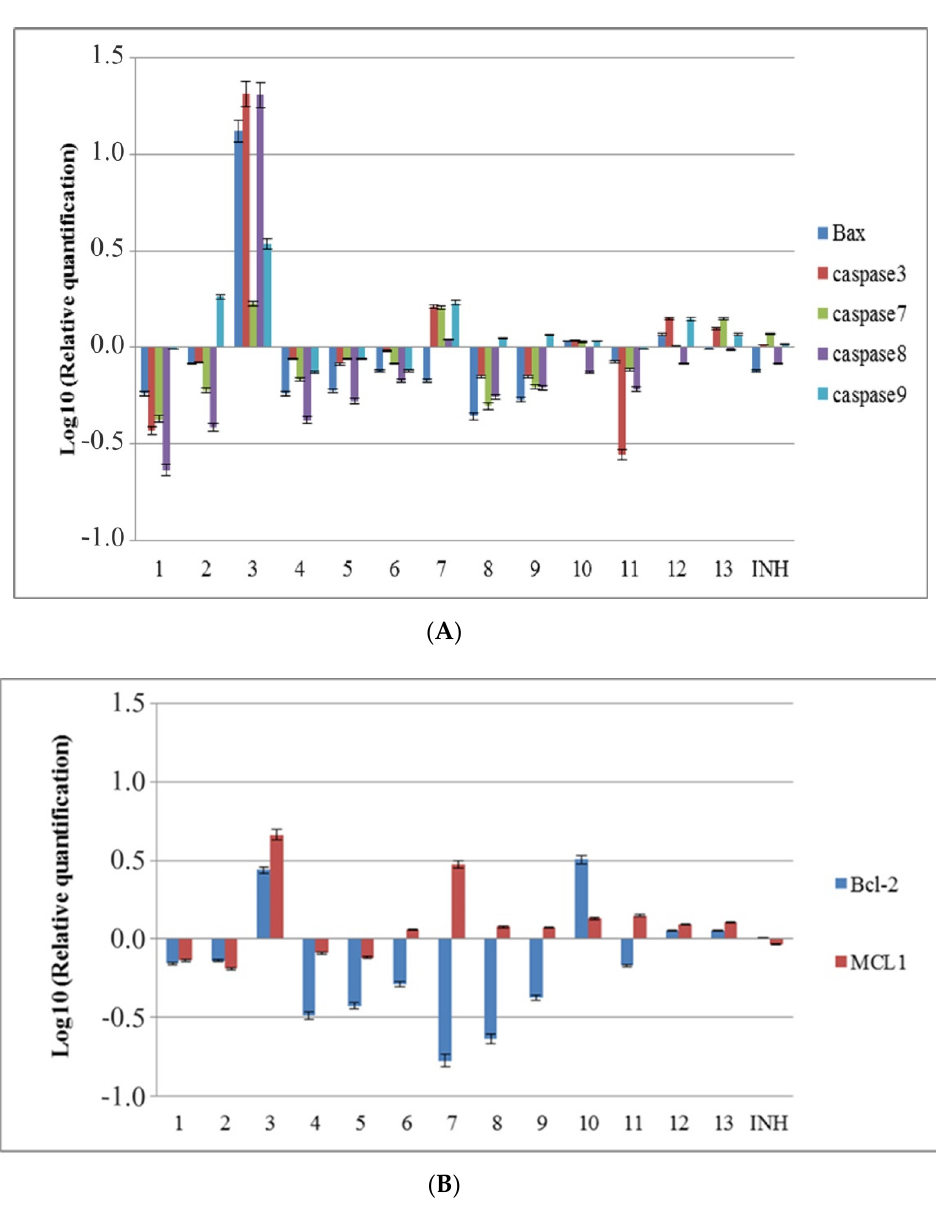
Figure 4. The influence of the new isoniazid derivatives on the expression of genes implicated in apoptosis induction in HCT-8 cells; ( A ) pro-apoptotic genes; ( B ) anti-apoptotic genes.